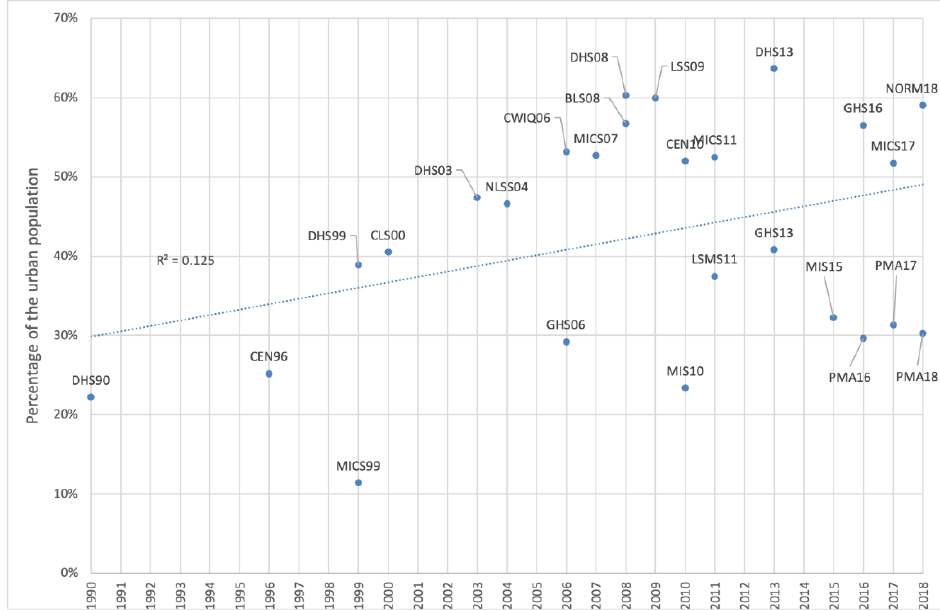
Figure 2. Change in proportion of urban population using wells as main drinking water source (%, Nigeria by survey).